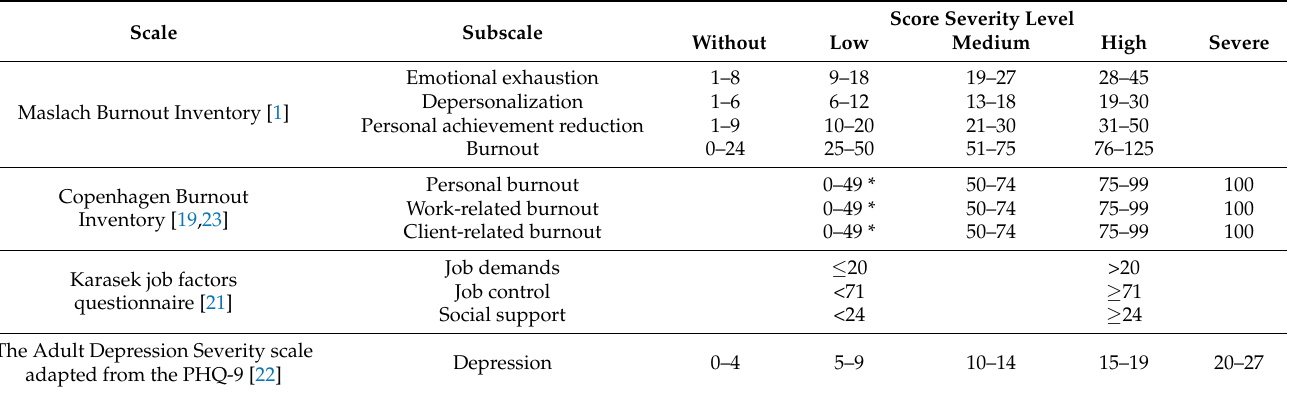
Table 1. Cut-off values for the